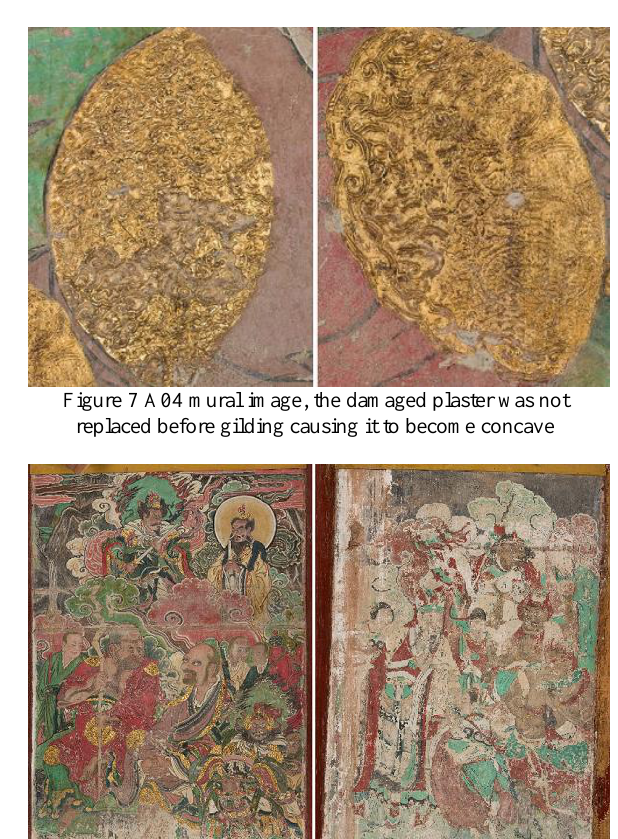
Figure 6 A03 mural image, the constructors painted the base black with white patterns